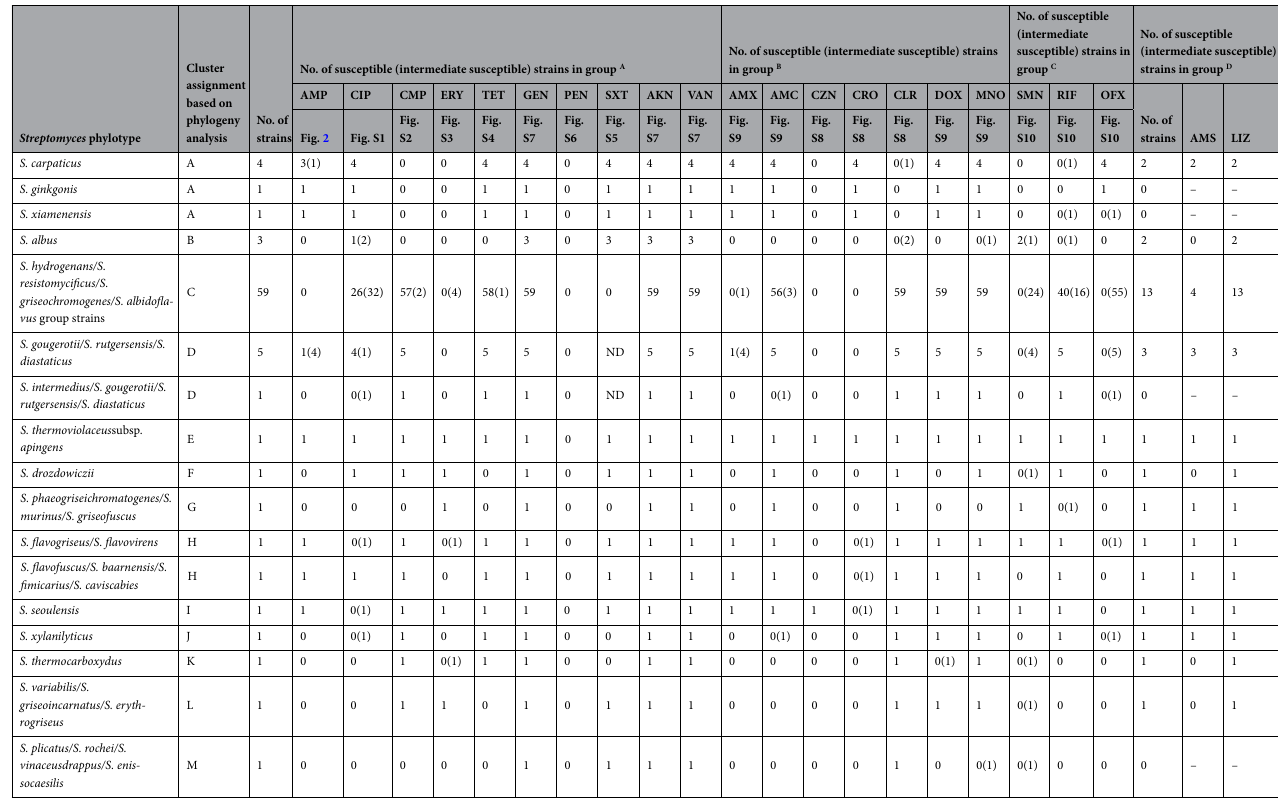
Table 3. Results of clinical isolates antibiotic susceptibility. Numbers represent the quantity of susceptible and intermediate susceptible (in the brackets) strains. Supplementary figures with details of the AST results are referred for each antibiotic. Abbreviations: ND – not determined. Note: A Breakpoints set by